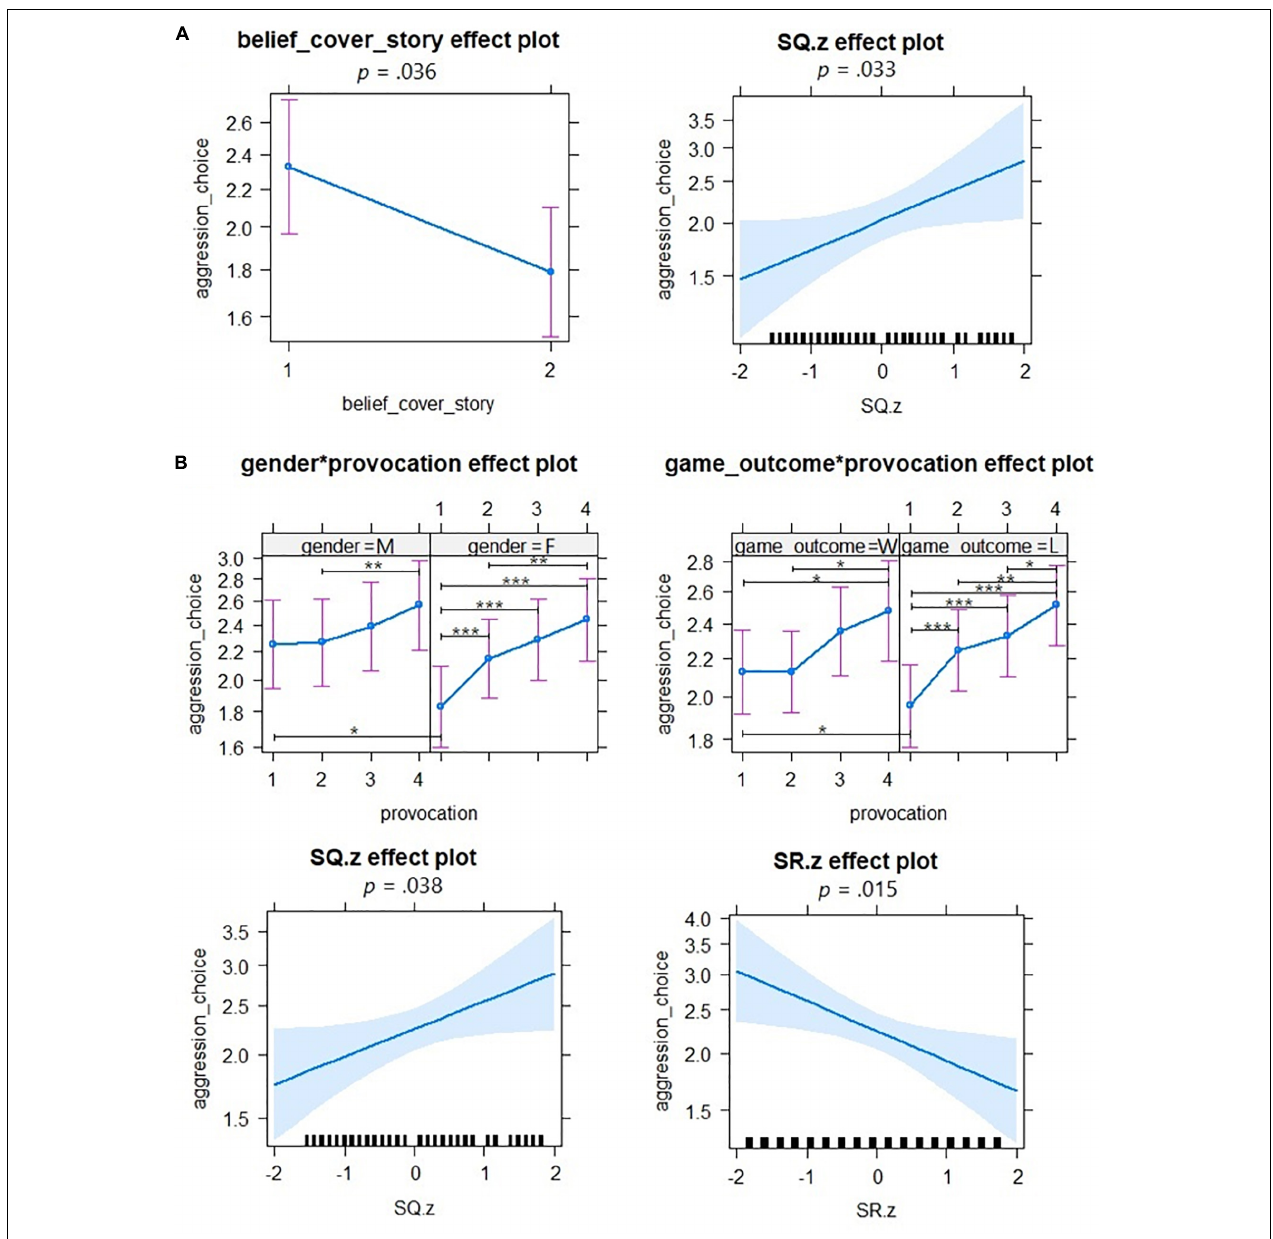
FIGURE 3 | Results of the generalized linear mixed-effects model analyses for the pTAP (A) and the rTAP (B) . In (A) , on the left: main effect of belief in cover story; on the right: main effect of self-reported levels of selfishness (SQ.z). In (B) , upper row (left): interaction effect between gender and provocation (M, males; F, females); upper row (right): interaction effect between game outcome and provocation (W, win; L, loss); bottom row (left): main effect of self-reported levels of selfishness (SQ.z); bottom row (right): main effect of self-reported levels of sensitivity to reward (SR.z, SR subscale of the SPSRQ). The thick black lines in the x -axis represent the z-transformed scores of the questionnaires (selfishness scores for the SQ.z and sensitivity to reward scores for the SR.z). The error bars depict confidence intervals (95%). * p < 0.05; ** p < 0.01; *** p <